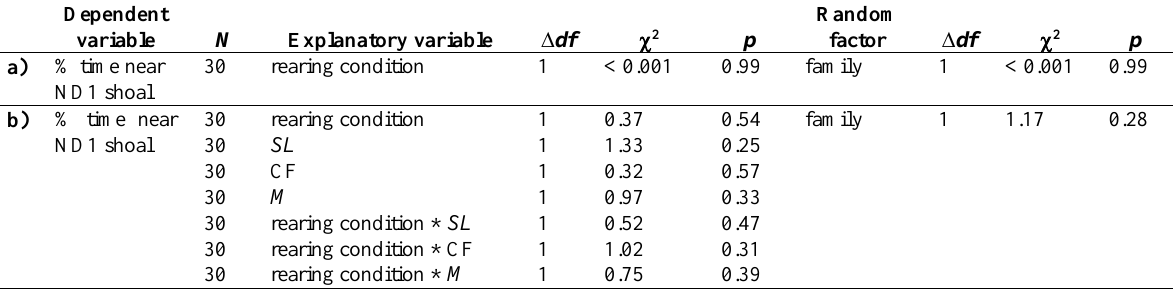
ND Shoal Choice Experiments. Analysis of variables affecting the proportion of time test fish reared either under UV+ or UV- lighting conditions spent near the shoal seen through the ND1